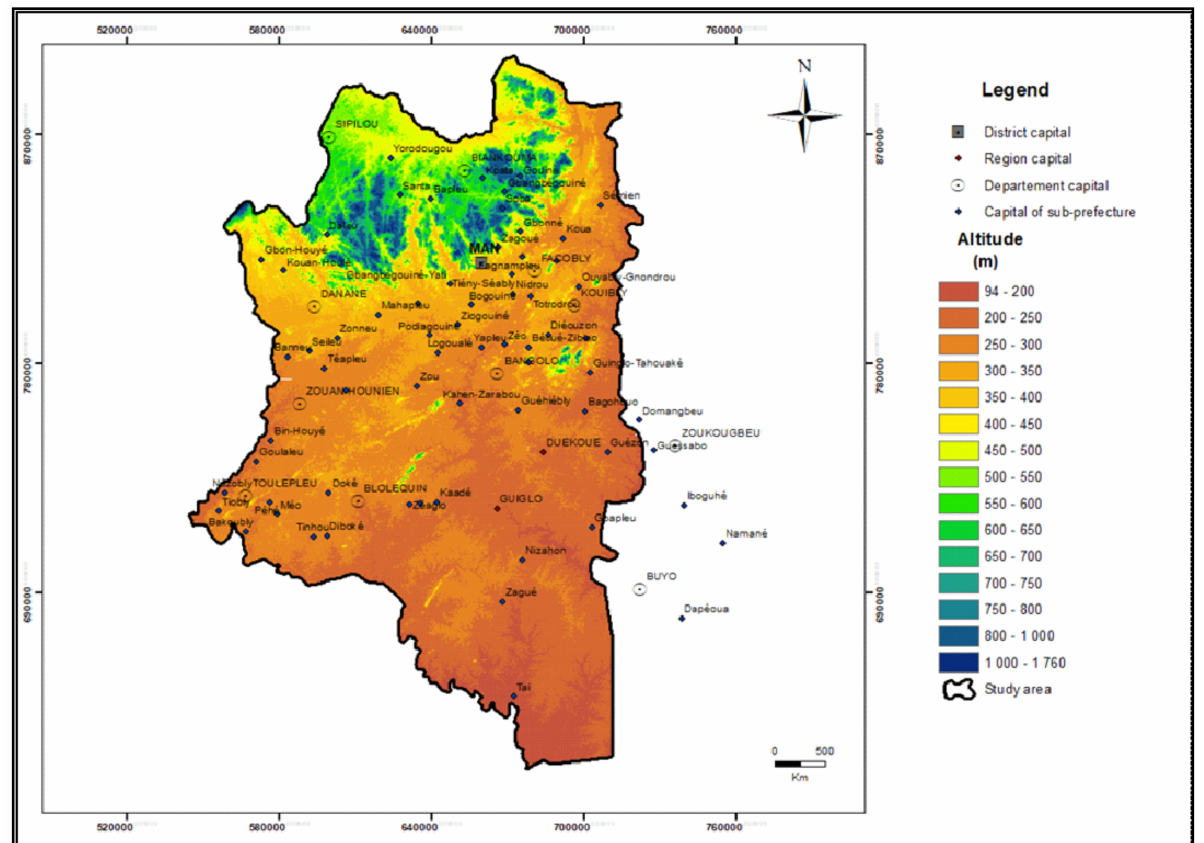
Figure 3. Topographic map of the Montagnes District in Western C ô te d’Ivoire (Data source: http://earthdata.nasa.gov/ (accessed on 12 March